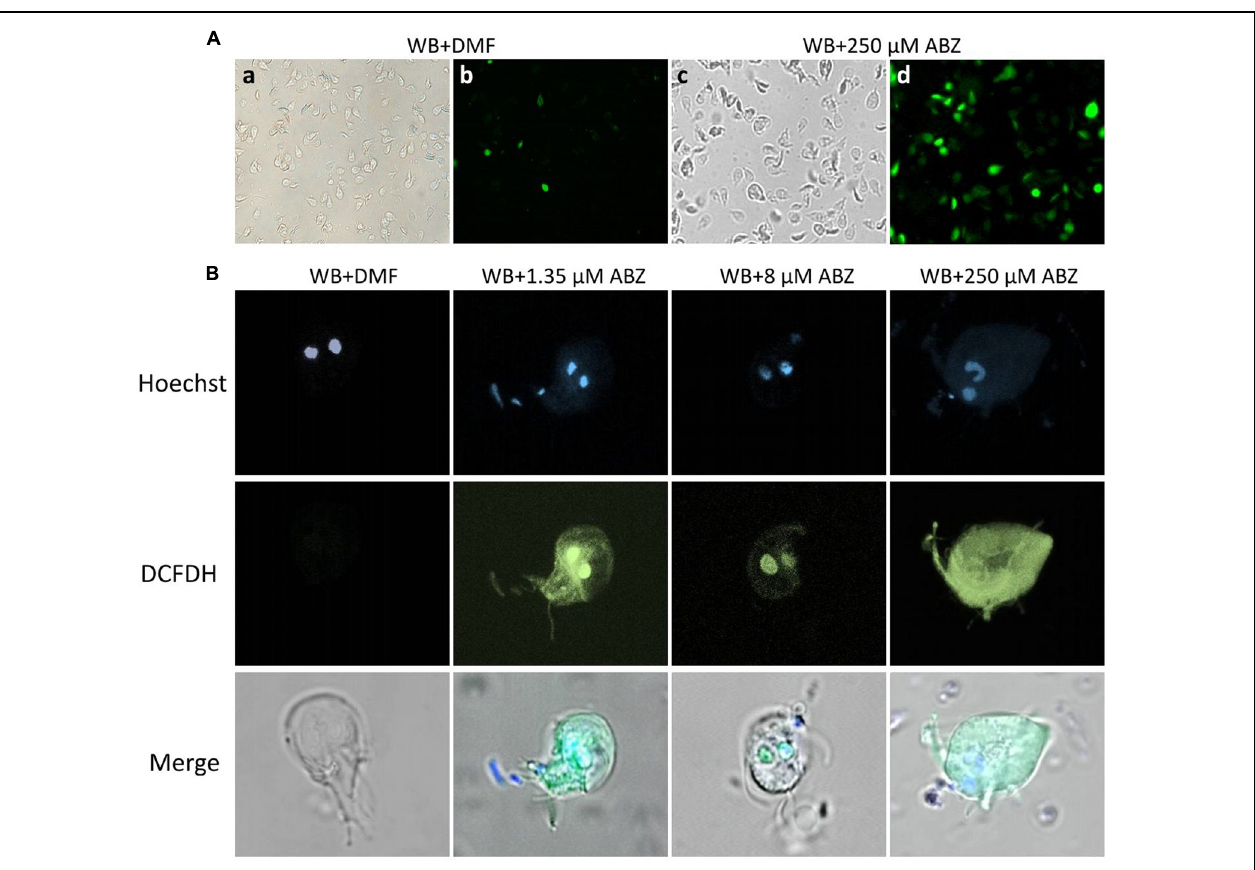
FIGURE 2 | Intracellular localization of ROS production in G. dudodenalis trophozoites exposed to ABZ. WB Giardia trophozoites were exposed to DMF or to the indicated ABZ concentrations (from left to right: 1.35, 8, and 250 μ M) for 8 h at 37 ◦ C. Cells were then incubated with DCFDH. Trophozoite micrographs are as follows: (A) top panel: representative images of trophozoites exposed to DMF (a,b) or to 250 μ M ABZ (c,d) and then incubated with DCFDH. Morphological changes in trophozoites (c BF) and ROS localization (d